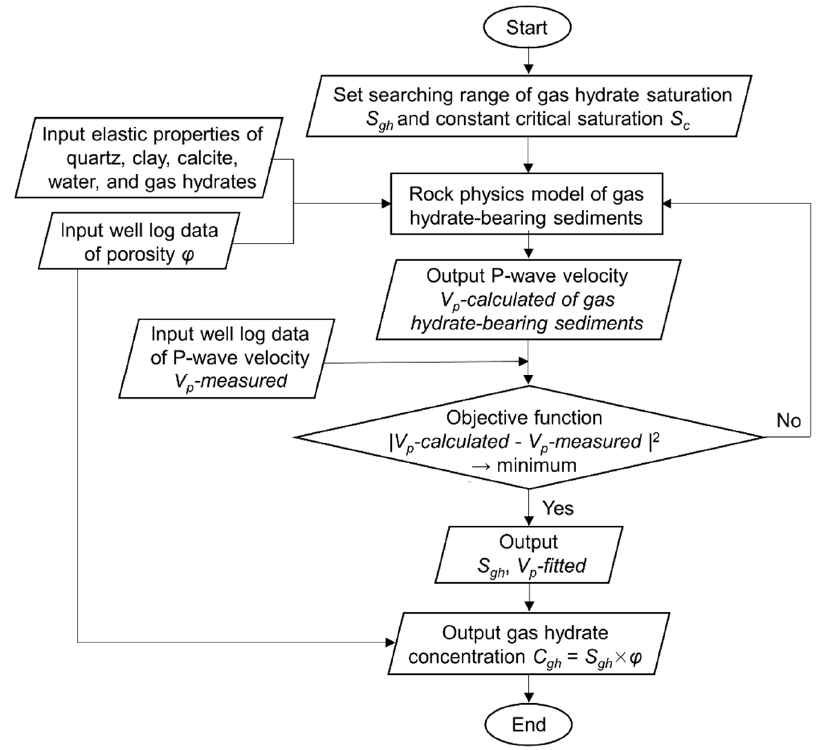
Figure 3. Flowchart of the prediction model of the gas hydrate concentration based on the well-log data.